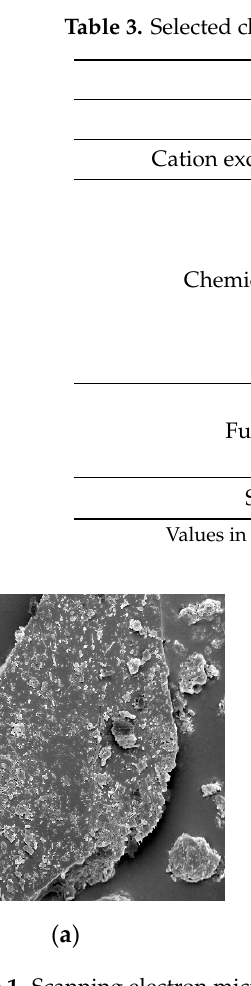
Figure 1. Scanning electron micrographs of clinoptilolite zeolite at ( a ) 10 µ m; ( b ) 4 µ m; and ( c ) 2 µ